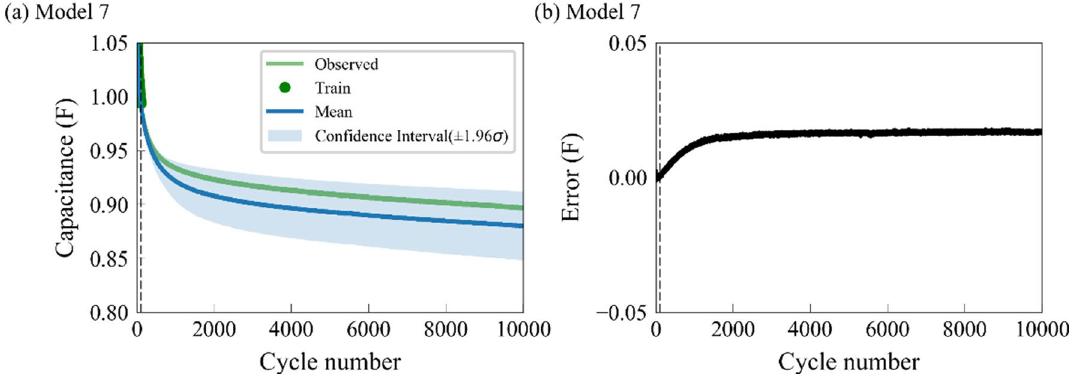
Figure 6. The prediction results of the Model 7, where only 1% of the cycles are used for training. The dotted line indicates the 100th cycle. ( a ) The predicted capacitance for Model 7 as a function of cycle number. ( b ) The predicted error (observed − mean) for Model 7. The curves and blue shaded areas denote the predicted training data and confidence interval,